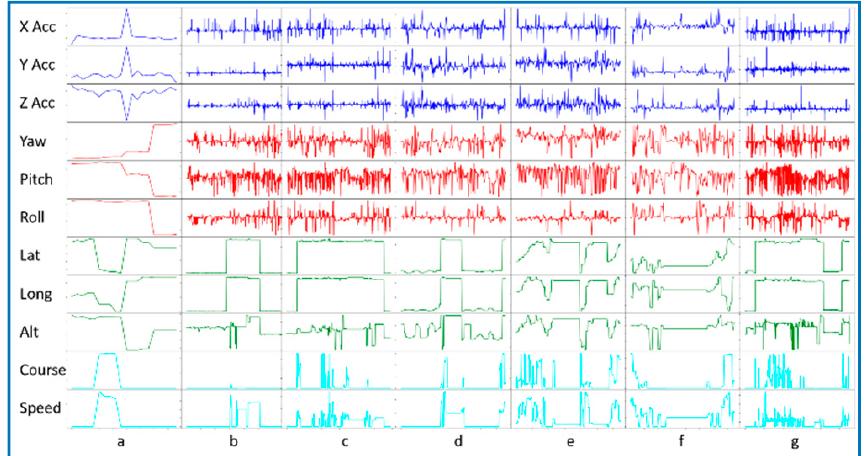
Figure 2. Graph displaying sensor values for a single user’s monitored activities. Sensed values are (x, y, z) acceleration, yaw, pitch, roll, latitude, longitude, altitude, course, and speed. The corresponding activity categories are a = sleep, b = work, c = eat, d = exercise, e = travel, f = hygiene, and g = hobby.